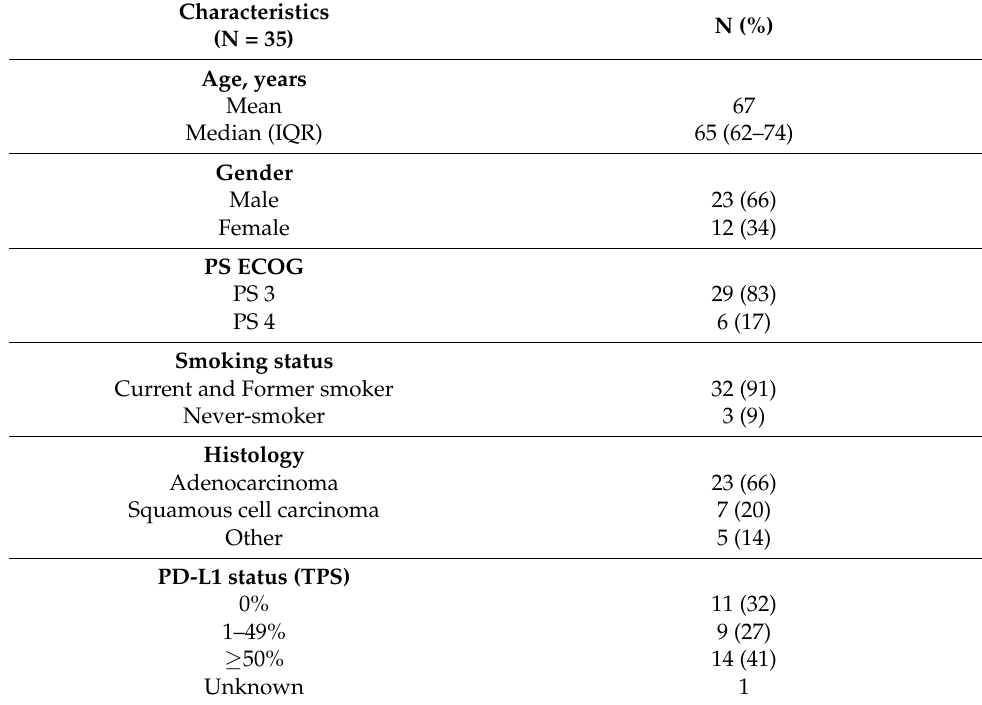
Table 1. Baseline Patient